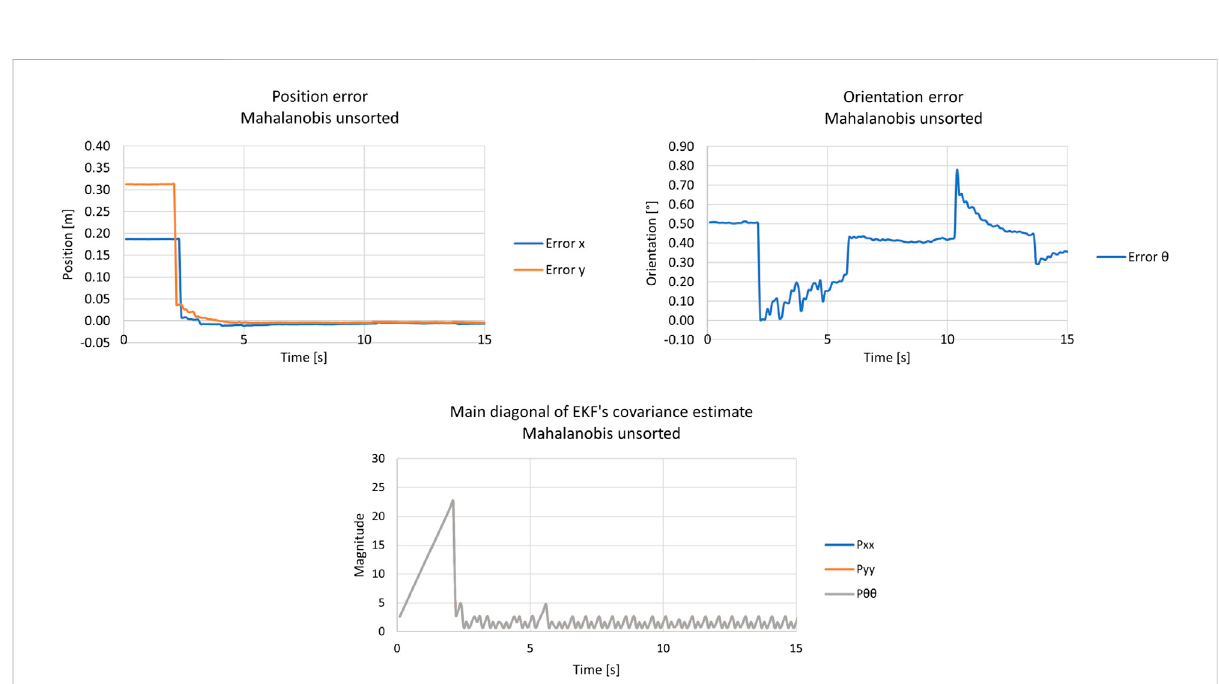
FIGURE 14 ResultsfromthekidnappedrobottestwiththeunsortedapproachandMahalanobis fi lter.TheUpperleftgraphrepresentsthepositionerror,the upper right displays the orientation error, and the bottom graph shows the main diagonal of the EKF ’ s covariance